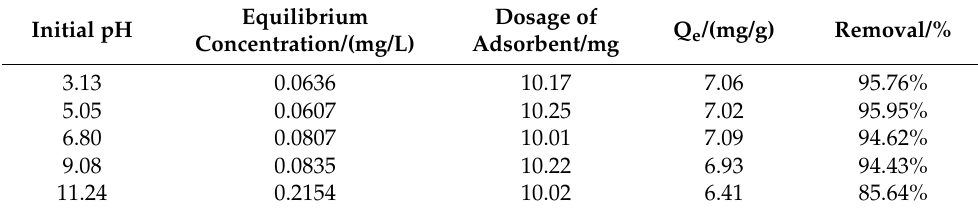
Table 3. Effect of pH on NaAsO 2 removal by